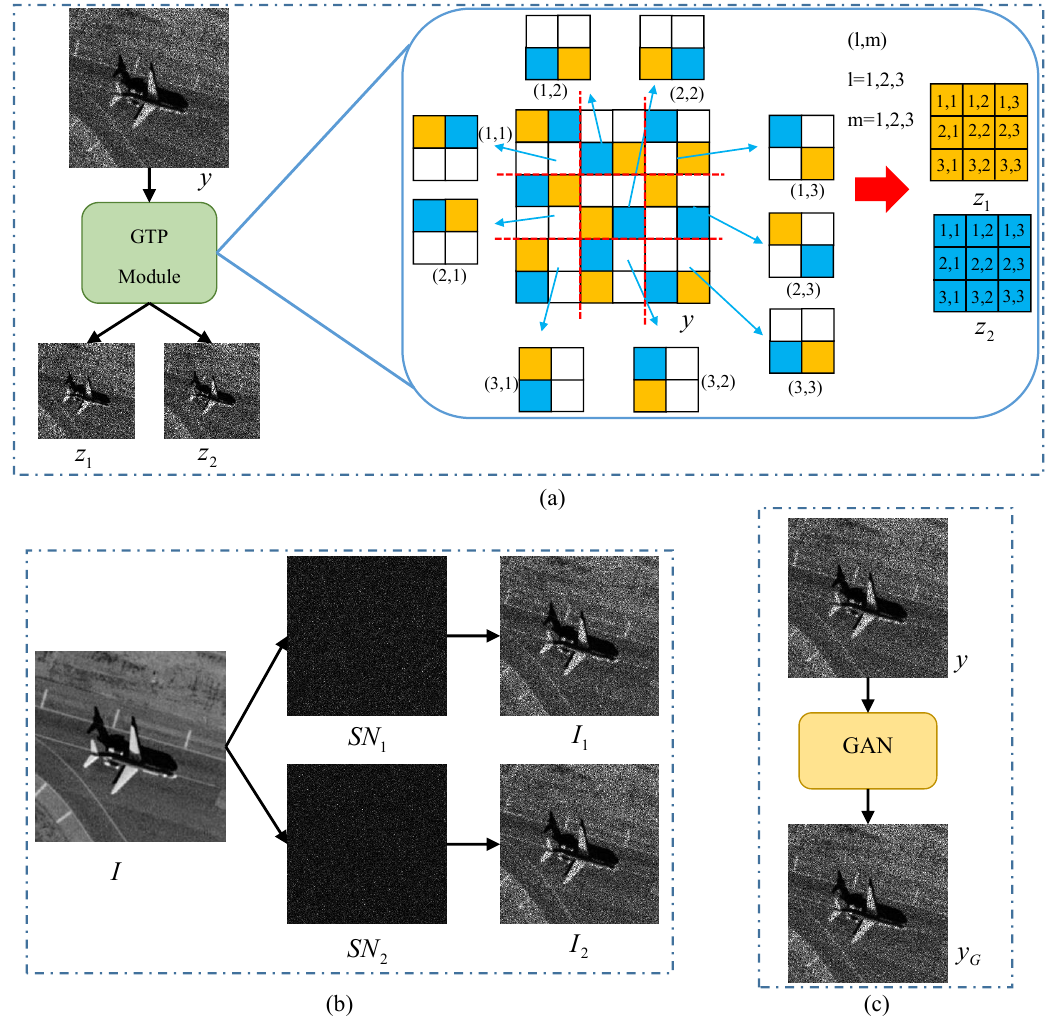
Figure 2. Comparison of different methods for generating noisy-noisy image pairs. ( a ) The method of proposed GTP module. ( b ) The method of using natural images. ( c ) The method of using